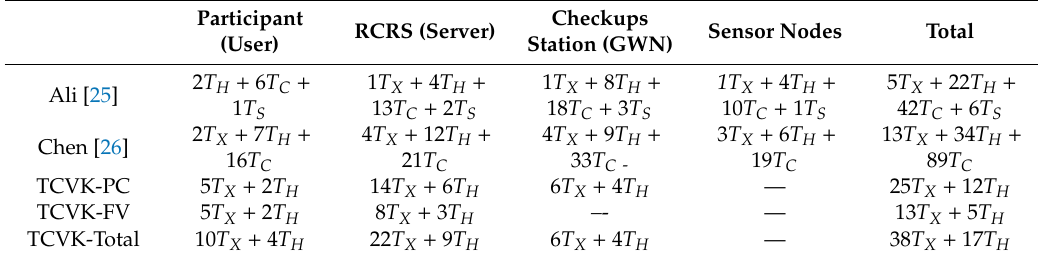
Table 2. E ffi cacy comparisons. Regular checkups records server